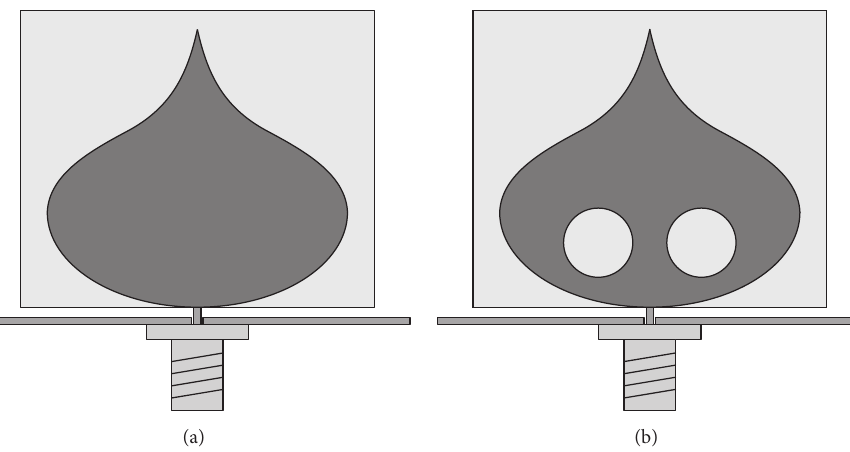
Figure 5: The PICA broadband antenna [23]. The design solutions (a) without holes and (b) with holes in the monopole are shown in the figure. Dark gray monopole and medium gray ground plane.